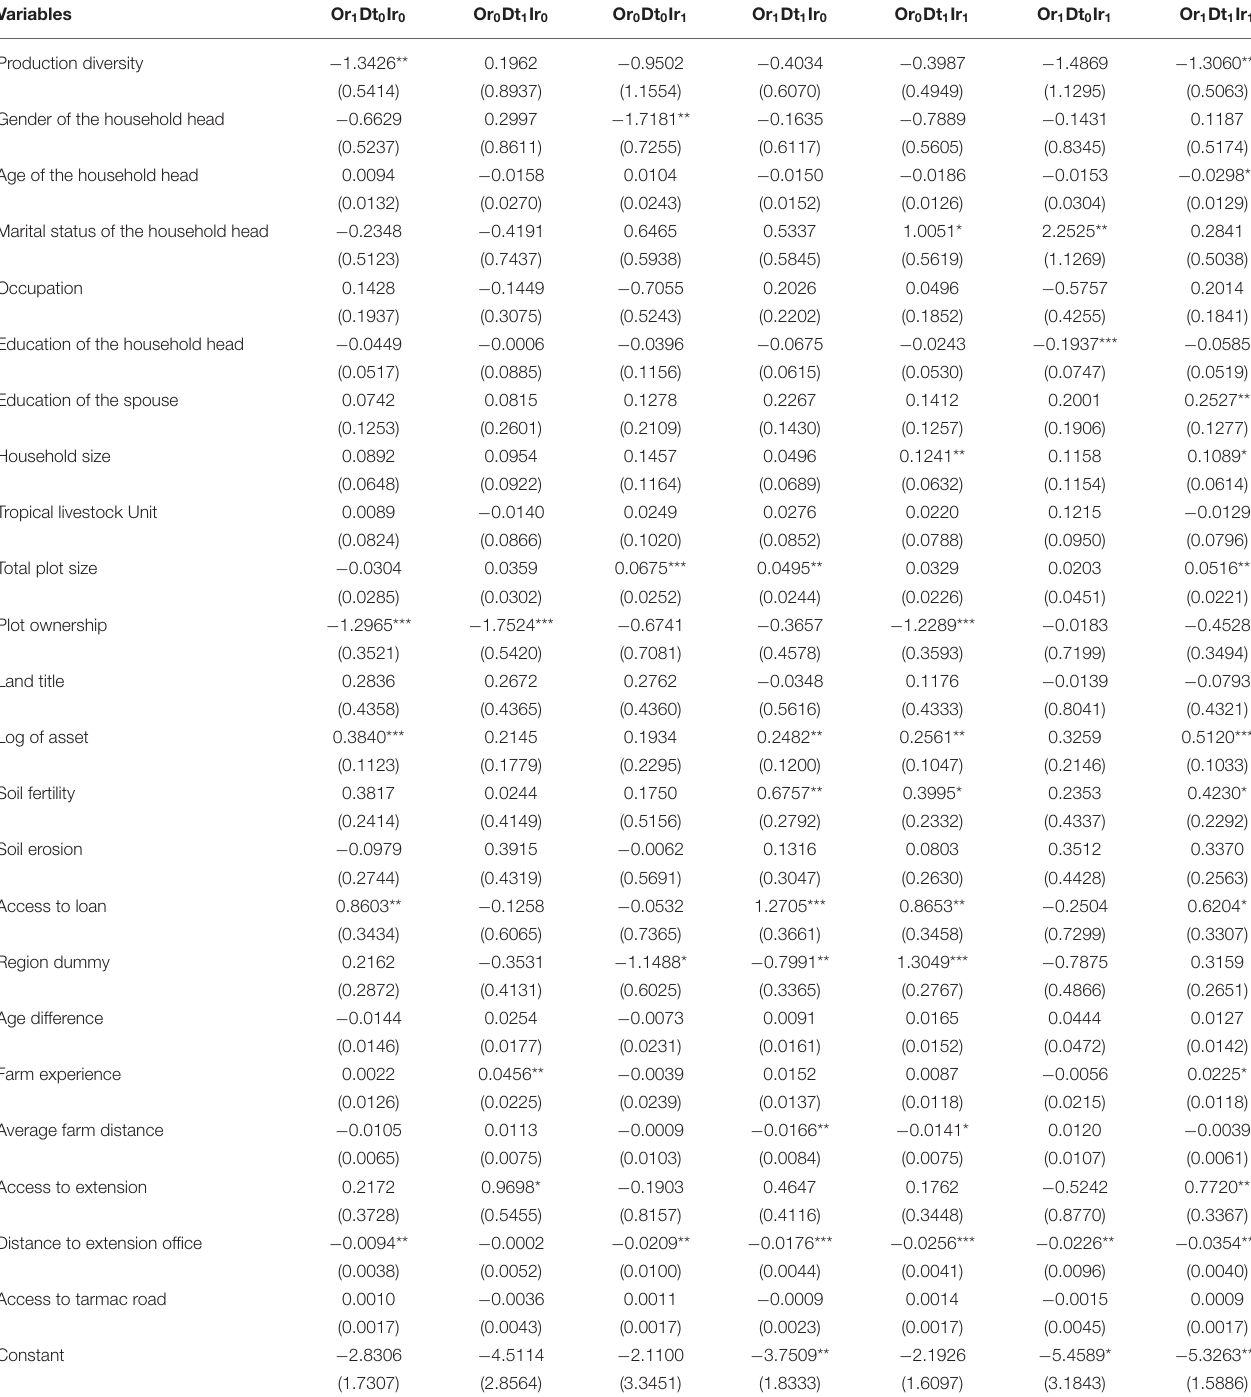
TABLE 2 | Parameter estimates of the mixed multinomial logit